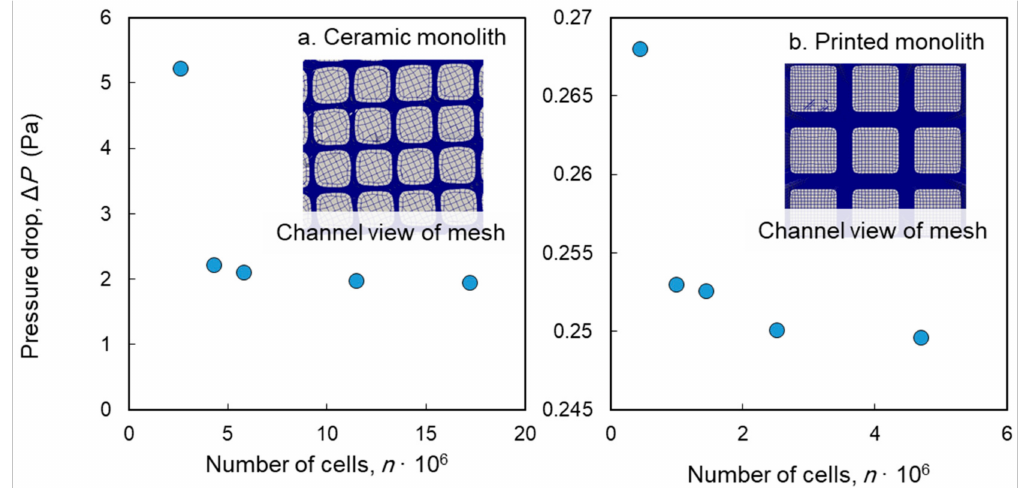
Figure 3. The grid independency test results for ( a ) ceramic and ( b ) printed monolith honeycombs. Both panels contain an inset showing a channel view of the final